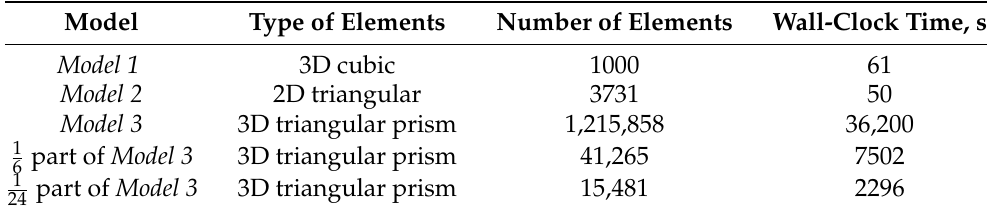
Table 1. Comparison of the